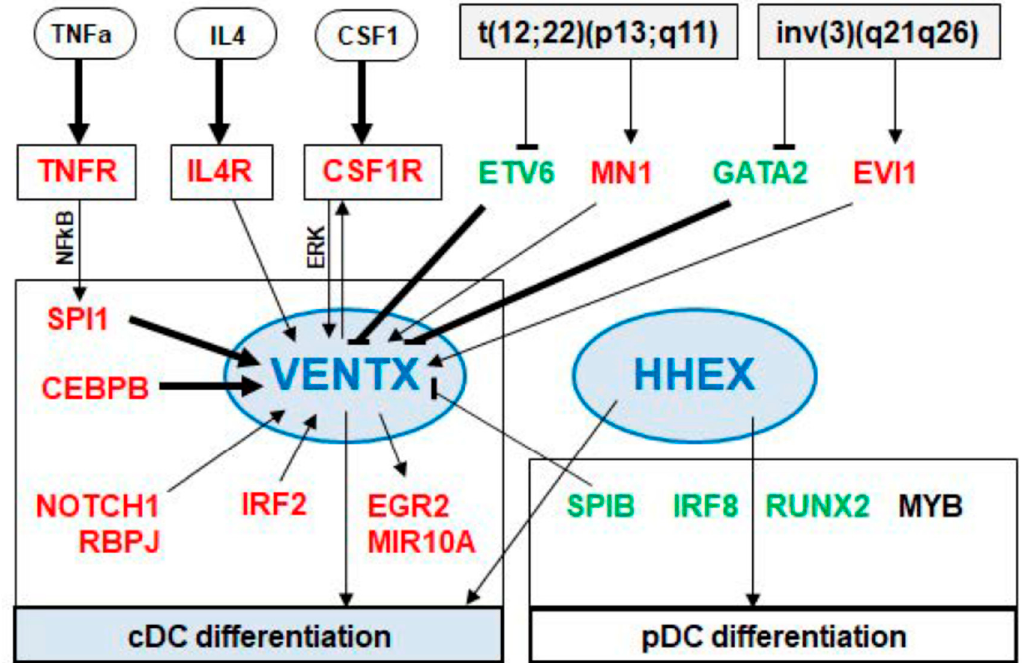
Figure 7. VENTX located in a gene regulatory network. This scheme summarizes the results of our study. The DC-associated NKL homeobox genes VENTX and HHEX are shown centrally involved in the differentiation of cDCs and pDCs. VENTX expression is activated by the TNFa-, IL4-, CSF1-, and NOTCH1-signaling pathways. The TFs SPI1, CEBPB, IRF2, MN1, and EVI1 activate VENTX while the TFs SPIB, ETV6, and GATA2 inhibit VENTX expression. Regulation by the TFs SPI1, CEBPB, ETV6, and GATA2 may operate directly as indicated by public ChIP-data (arrows in bold). The TFs ETV6, MN1, GATA2, and EVI1 are targeted by the chromosomal aberrations t(12;22)(p13;q11) and inv(3)(q21q26). Indicated VENTX target genes are CSFR1, EGR2, and MIR10A.